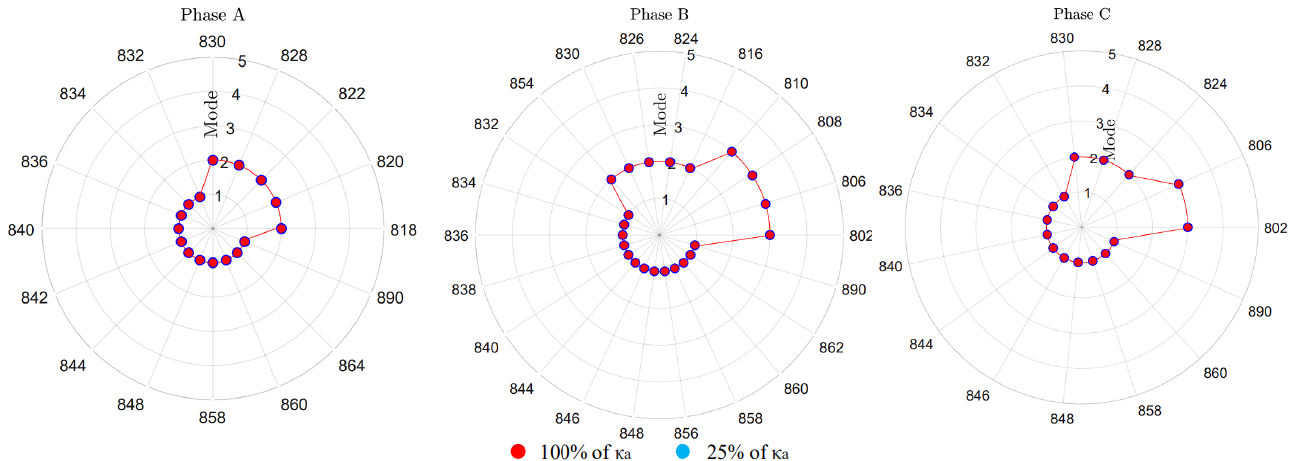
Figure 17. Operation modes using the proposed method for three-phase